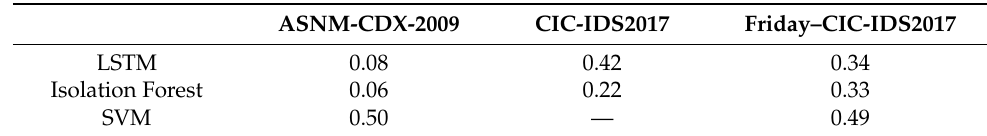
Table 11. F1-scores of all tested